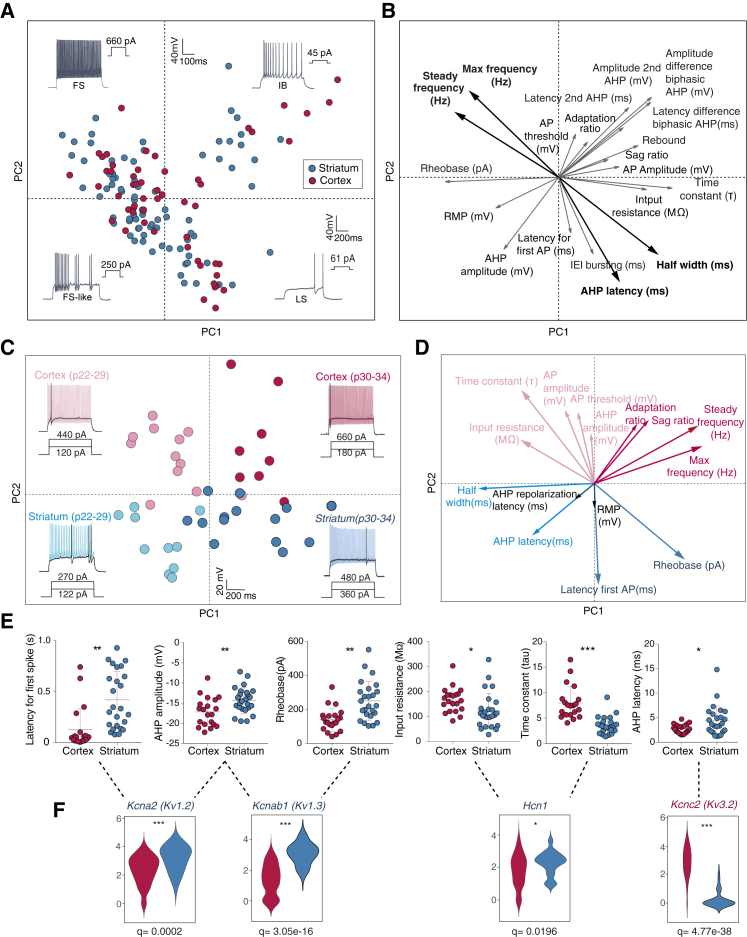
Pvalb-Expressing Interneurons from Striatum and Cortex Exhibit Distinct Intrinsic Properties that Match with Gene Expression(A) PCA using 19 electrophysiological parameters acquired from recordings of 135 cortical and striatal interneurons using Pvalbcre and 5HT3aEGFP mouse lines.(B) Vector factor map analysis showing the parameters used in the PCA in (A) and their contribution (arrow size).(C) PCA based on 15 electrophysiological parameters obtained from Pvalbcre+ cells recorded in layer 5 S1 cortex and dorsolateral striatum. Representative traces are shown in each quarter.(D) Vector factor map analysis showing the parameters used for the PCA in (A) and their contribution (arrow size).(E) Selected parameters that were significantly different between cortical (20) and striatal (25) Pvalbcre+ cells, tested using unpaired t test Benjamini-Hochberg correction for multiple testing (Table S5). Error bars represent mean ± SEM.(F) Expression of selected differentially expressed ion channels involved in fast-spiking behavior in Pvalbcre+ cells. Differential expression was tested upon log transforming the data, using unpaired t test with Benjamini-Hochberg multiple testing correction (Figure S6). FS, fast spiking; FS-like, fast spiking like; IB, intrinsic bursting; LS, late spiking; BiaRS, biphasic AHP regular spiking.See also Figures S6 and S7 and Table S5.